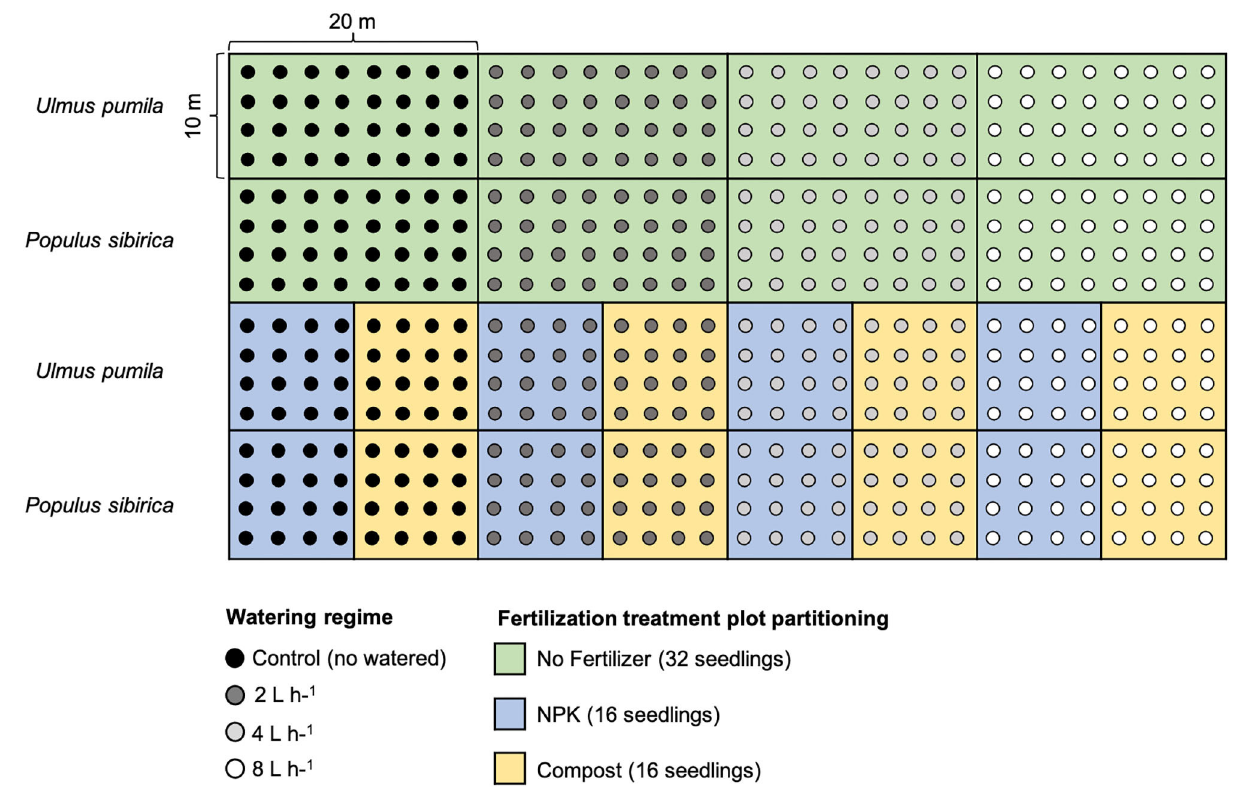
FIGURE 1 | Planting scheme of the afforestation site. Green rectangular area (20 × 10m) indicates the watering-only treatment (no fertilizers) with 32 seedlings for each of the watering regime. Light blue square areas (10 × 10m) indicate the NPK fertilization with 16 seedlings for each of the watering regime. The yellow square areas (10 × 10m) indicate Compost fertilization with 16 seedlings for each of the watering regime. Areas of the upper rows refer to Ulmus pumila tree plantation while areas of the lower rows refer to the Populus sibirica tree plantation. Black dots are relative to control trees (no watered), dark gray dots indicate 2L h − 1 watered trees, light gray dots indicate 4L h − 1 watered trees, and white dots indicate 8L h − 1 watered